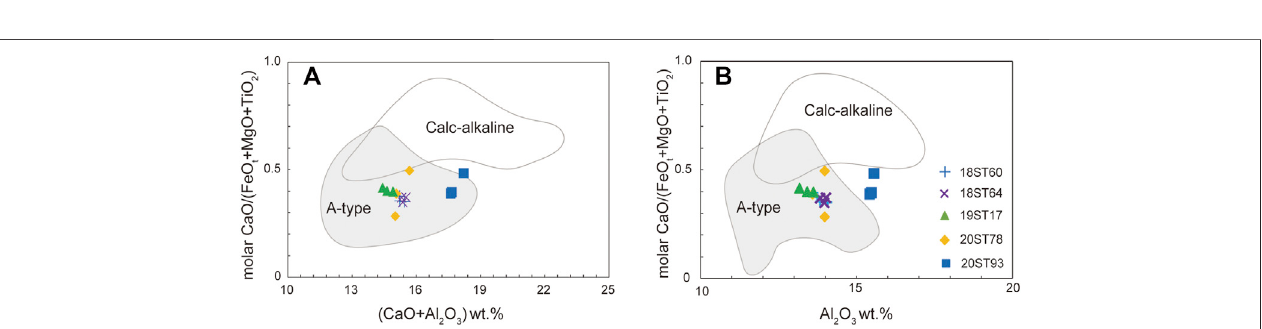
FIGURE 11 | Whole-rock CaO/(FeO t + MgO + TiO 2 ) vs. CaO + Al 2 O 3 (A) and CaO/(FeO t + MgO + TiO 2 ) vs. Al 2 O 3 (B) diagrams (after Dall ’ Agnol and de Oliveira, 2007) showing the A-type af fi nity of the studied Permian granitoids.